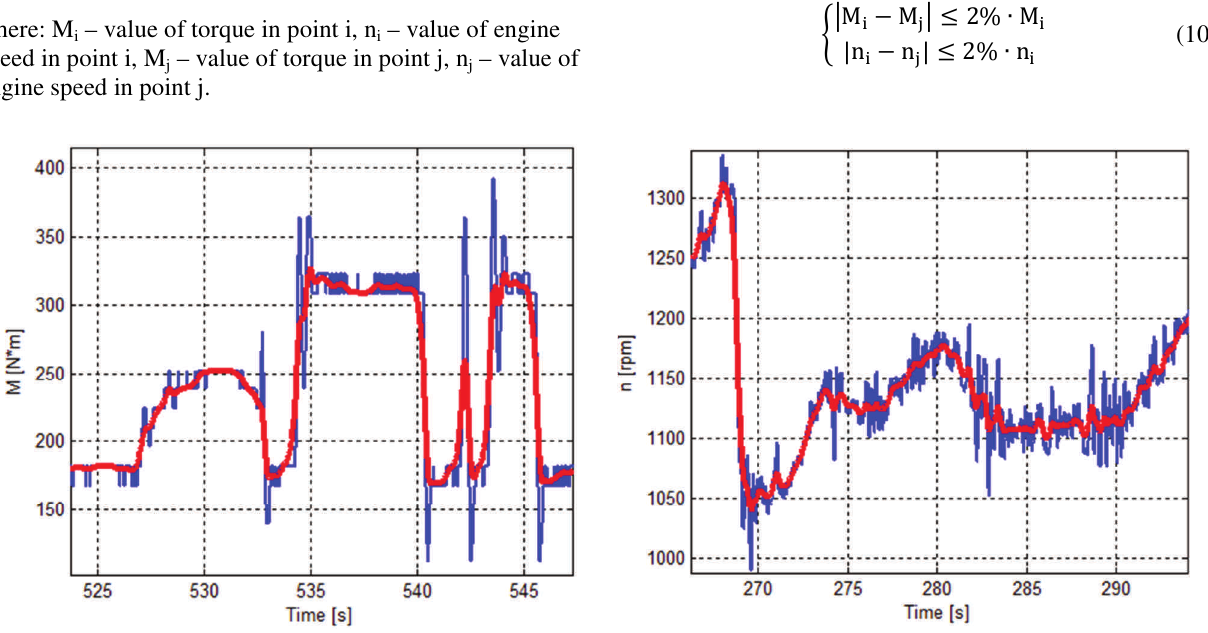
Fig. 1. Measuring points of engine speed (n) and torque (M) before (blue) and after filtration (red) It is impossible to obtain constant values of parameters in real conditions, but their fluctuation can be